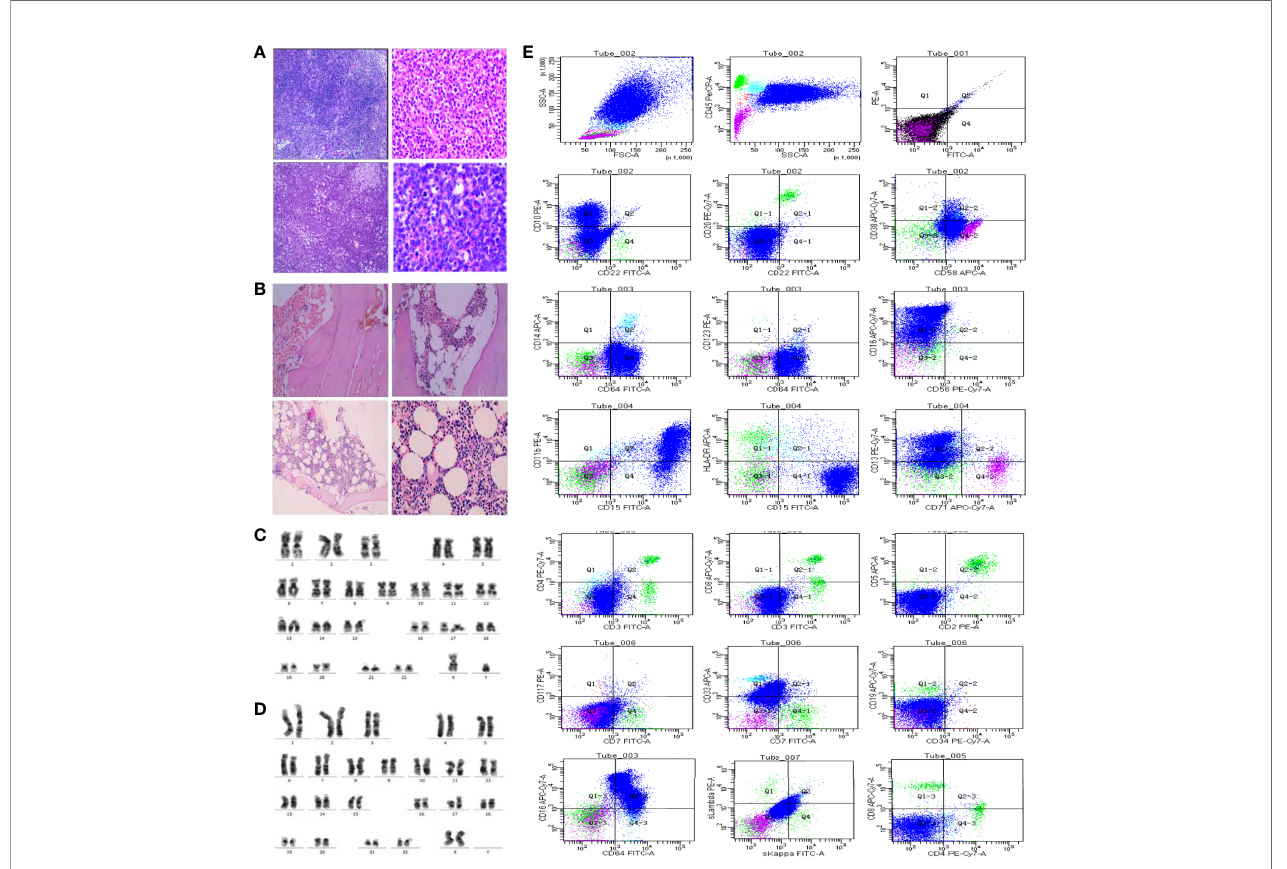
FIGURE 2 | (A) HE staining pictures of patients 1 and 2. The above two pictures show patient 1; the bottom two pictures show patient 2 (left: 10×10, right: 10×40). (B) Histopathological examination of the bone marrow of patients 1 and 2: the above two pictures showed patient 1; the bottom two picture showed patient 2. (C, D) Chromosome karyotype analysis of the two patients. (E) Flow cytometry analysis showed that lymphocytes accounted for 9.5% of nuclear cells, and the proportion decreased in patient 1. The proportion of B lymphocytes increased. However, no obvious light chain restriction was found. Primitive region cells account for about 0.5% of nuclear